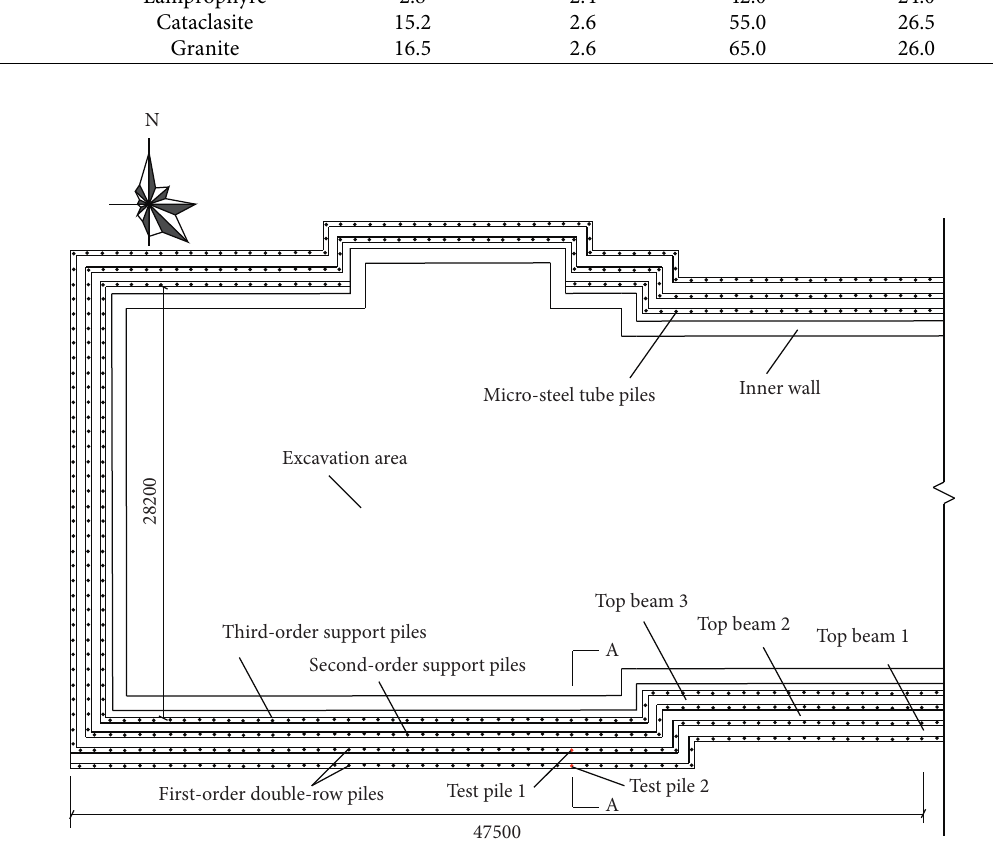
Figure 1: Plan of the foundation